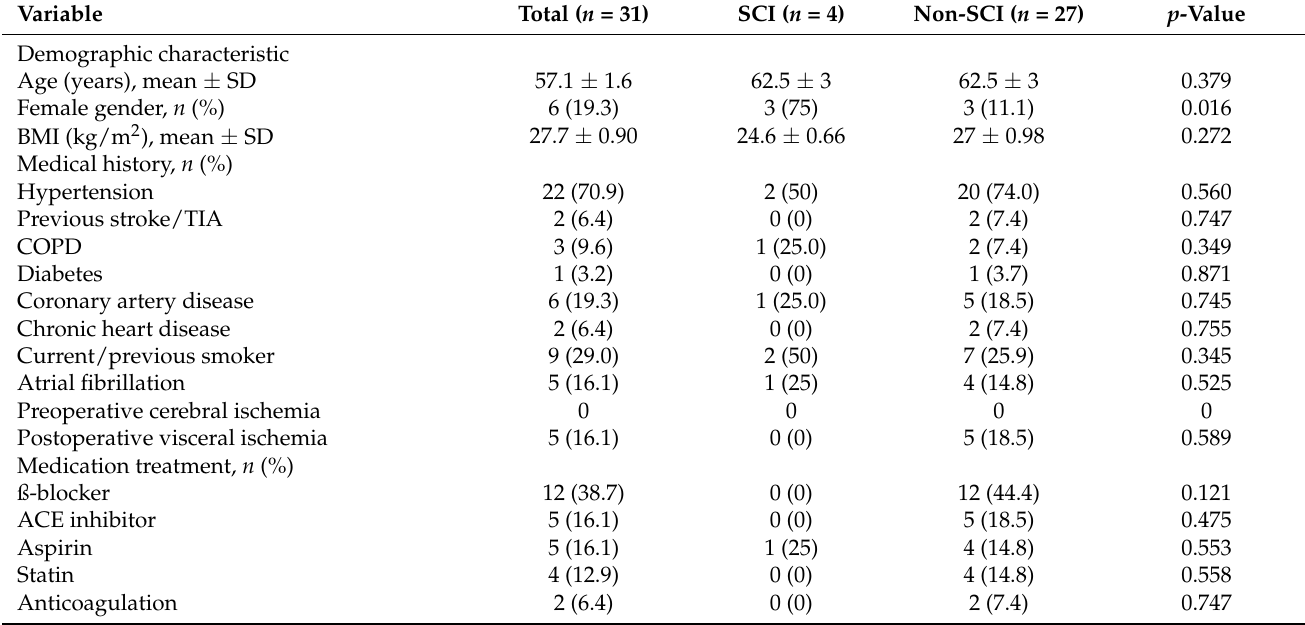
Table 1. Baseline characteristics of the study